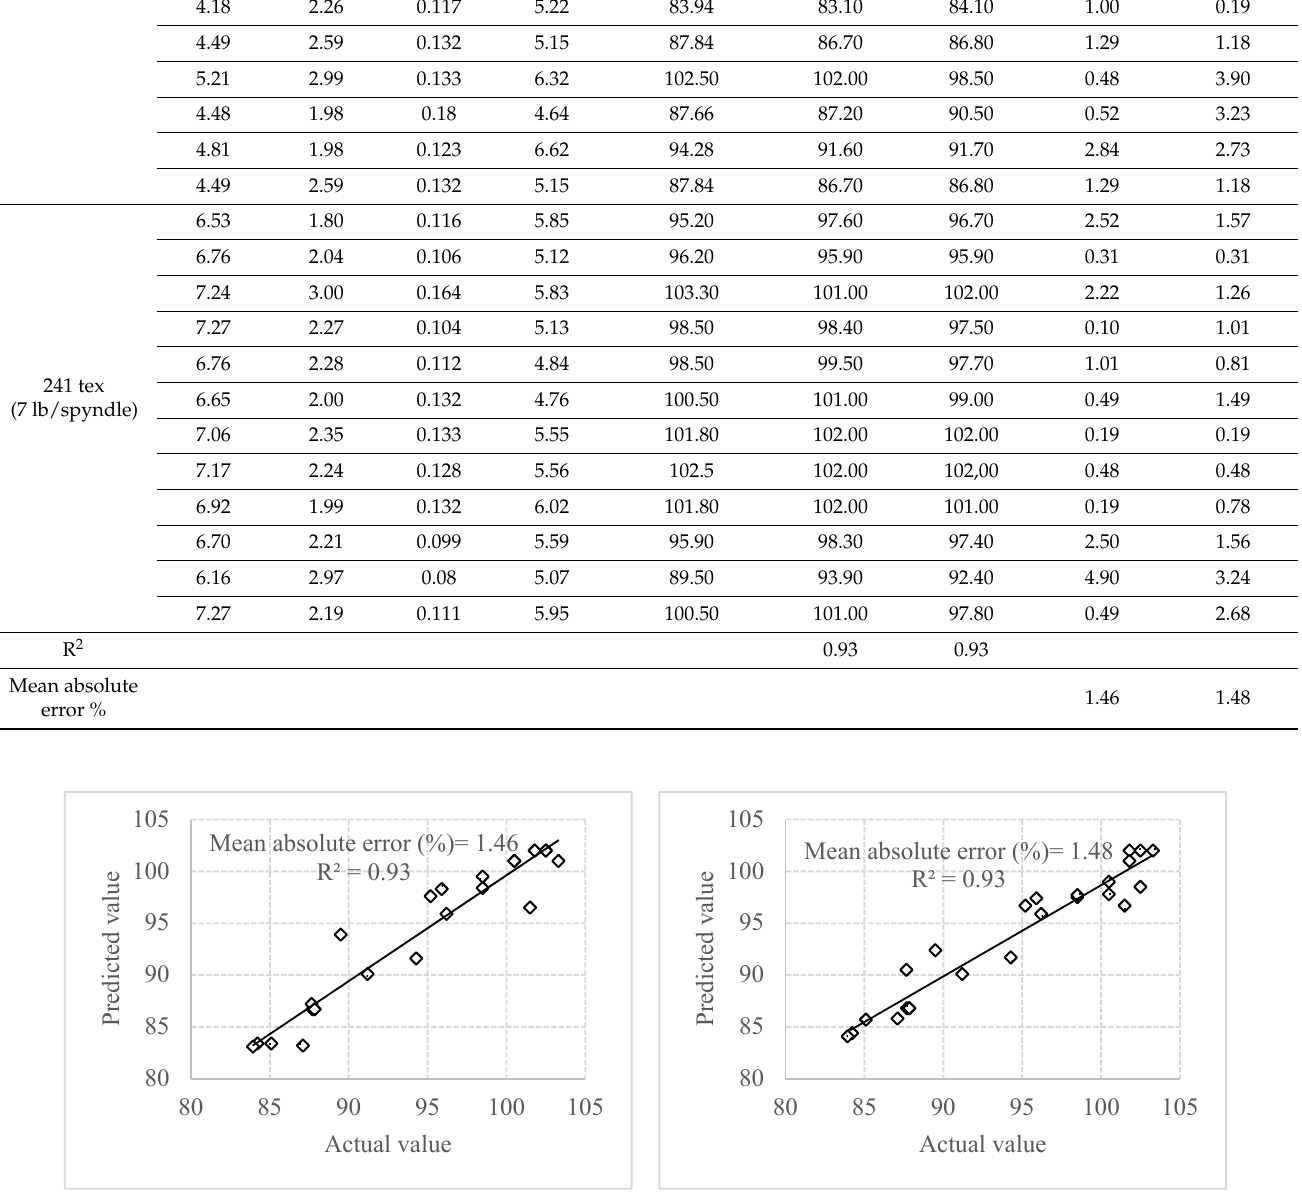
Figure 10. Surface view of tenacity at break (X-axis) and strain at break (Y-axis) effect on jute yarn quality (Z-axis); ( a ) for triangular membership function and ( b ) gaussian membership function.